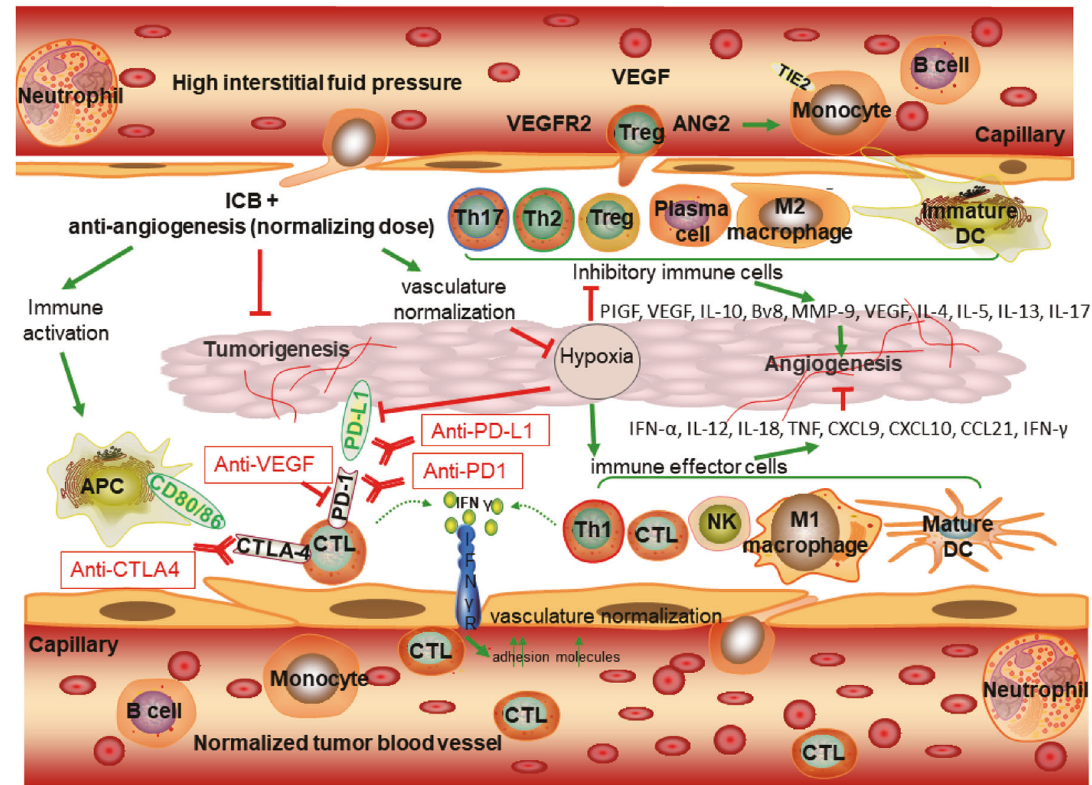
Fig. 1 Mechanistic rationale for immune checkpoint blockade in combination with anti-angiogenic agents. Combinatorial therapy activates the immune response and suppresses the inhibitory immune signals by decreasing the expression of multiple immune checkpoints, increasing the ratio of anti-/pro-tumor immune cells, and alleviating hypoxia by normalizing tumor